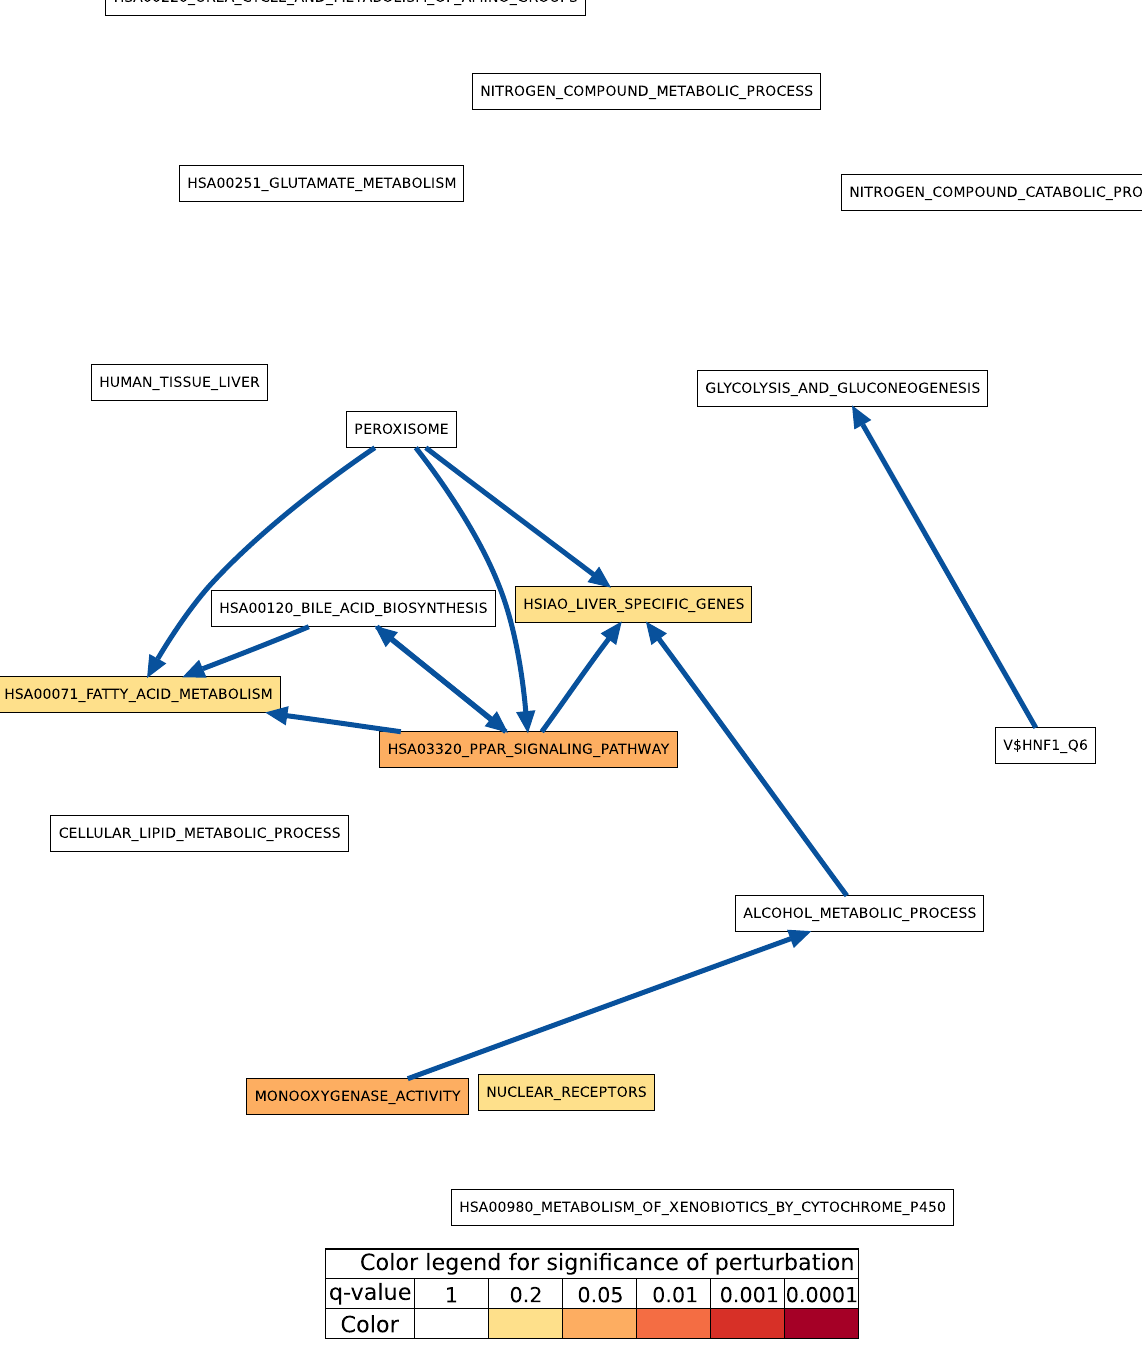
Figure 1. CS vs. HM CBPLN on day 1. In this figure and all other figures displaying CBPLNs, each node is one of the gene sets in Table 2. An edge connects two gene sets whose linkage is determined to be statistically-significant by both hypothesis tests used in computing CBLPNs. The color of a node indicates the statistical significance of its perturbation, as computed by GSEA [6]. The legend mapping colors to ranges of statistical significance appears at the bottom of the figure. We use the same color scheme to indicate the statistical significance computed for a gene set by GSEA and for the significance value computed for a gene by LIMMA. We use this color scheme in all the subsequent figures as well.